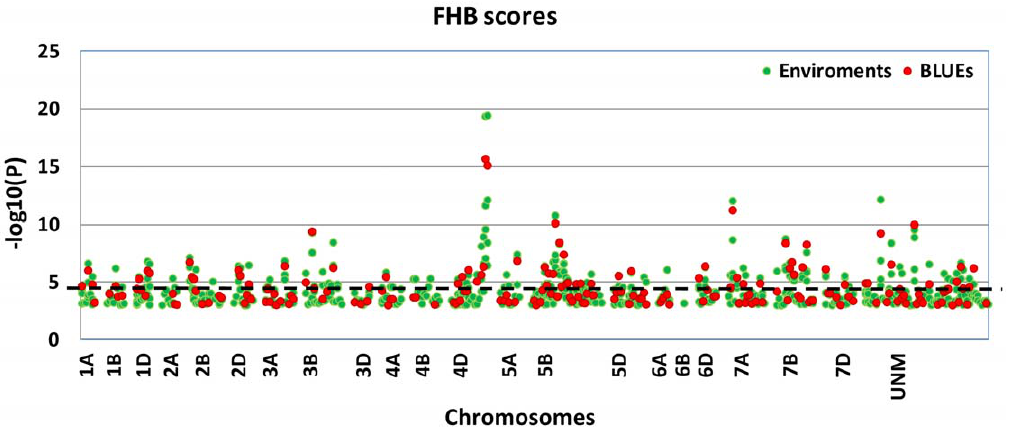
Figure 4. Manhattan plots of marker-trait associations for FHB resistance. The plot represents the individual significant 2 log 10 (p) . 3.0 marker-trait associations of four environments plus BLUEs sorted according to their chromosomal location. The dotted line indicates the threshold of 2 log 10 (p)=4.82 for Bonferoni correction. All markers which were not associated or associated with a 2 log 10 (p) below 3.0 were set to 0. Green dots represent the MTA of a single environment, red dots represent the MTA of a BLUE value.